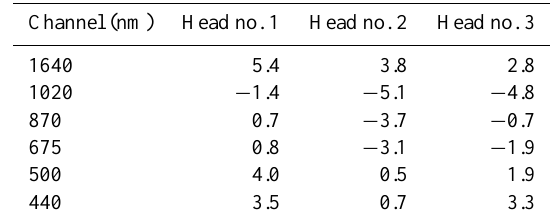
Table 1. Relative differences (in %) in calibration coefficients ex- tracted by means the Sun-Moon gain factor method and the Lunar Langley method for three different heads calibrated at Izaña.